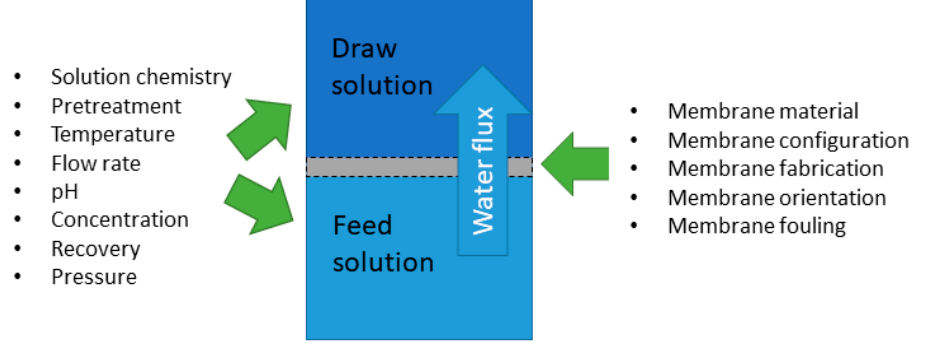
Figure 4. Factors affecting osmotic membrane processes. Figure 4. Factors a ff ecting osmotic membrane